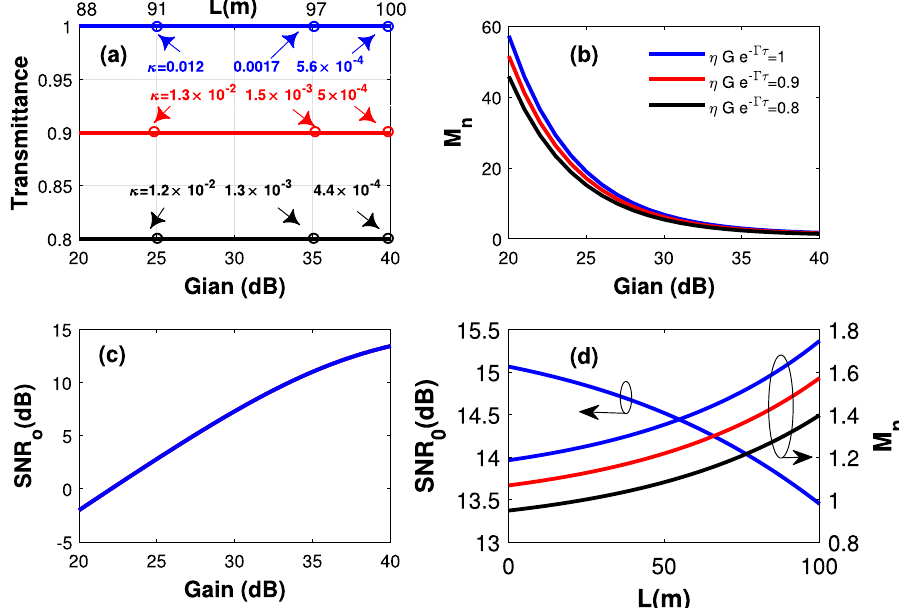
Figure 2. ( a ) The signal transmittance versus the gain. Here, the waveguide length l = 100 m. ( b ) The number of induced noise photons ( M n ) versus the gain. Here, the waveguide length l = 100 m. Different signal transmittance are considered. ( c ) The signal-to-noise ratio versus the gain. Here, the waveguide length l = 100 m. ( d ) The signal-to-noise ratio and the number of induced noise photons ( M n ) versus the waveguide length. Here, the gain G = 40 dB. Different signal transmittances are